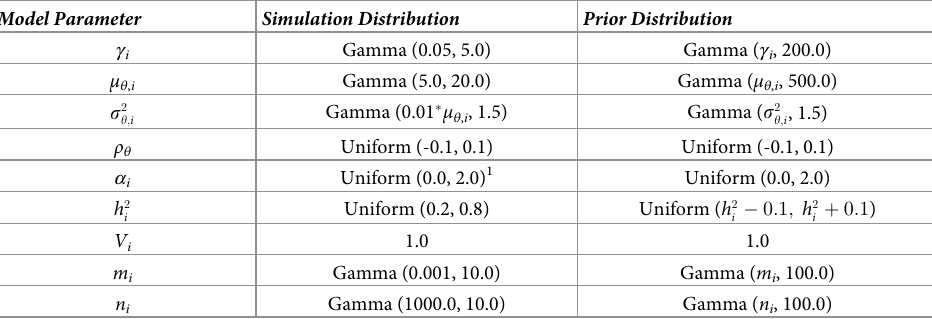
Table 3. Distributions for simulation parameters and refined prior